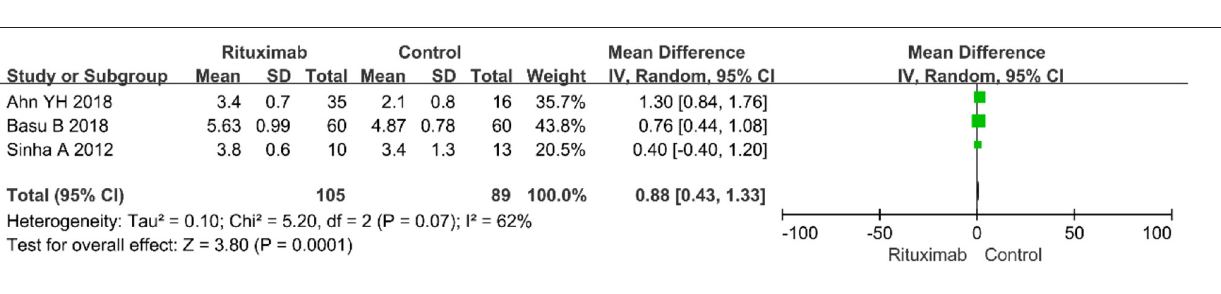
FIGURE 4 | Forest plot showing a meta-analysis of serum albumin between rituximab treatment group and control group.